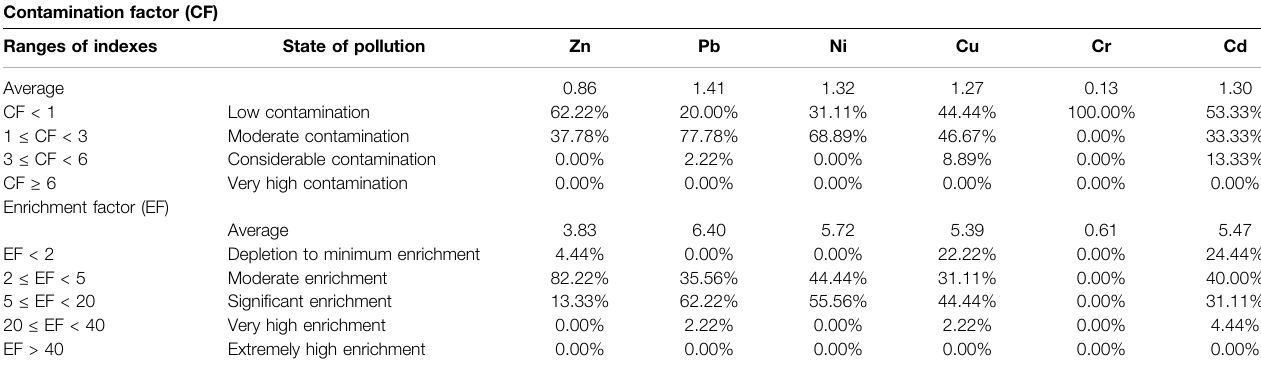
TABLE 5 | Evaluation results in contamination factor (CF) and enrichment factor (EF) percentage (%) in the surface sediments of the Jian and Moyang rivers. Contamination factor (CF) Ranges of indexes